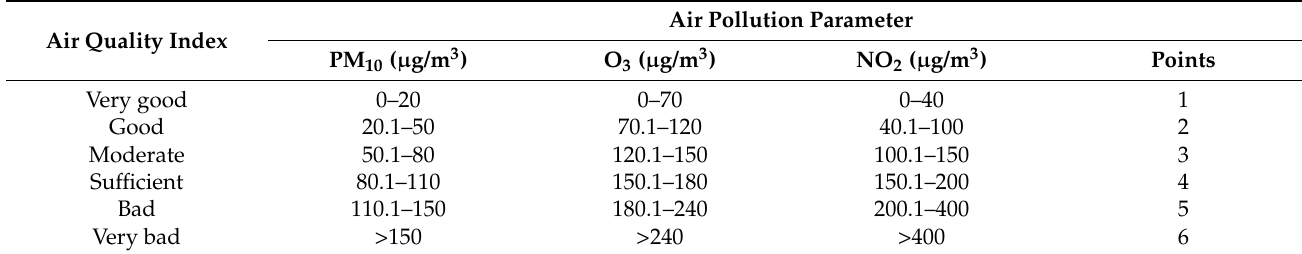
Table 1. Inspectorate of Environmental Protection (Poland) norms for hourly concentrations and assigned point values. Air Quality